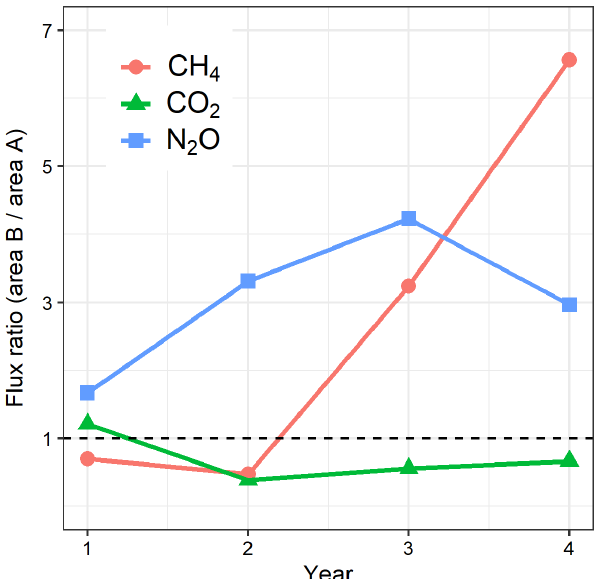
Figure 6. Ratios of annual soil GHG fluxes in area B (mature stand, felled after year 1) to that in area A (mature spruce stand, remain- ing) in Harwood Forest. Note: CH 4 fluxes are presented as absolute values. The dashed line represents ratio = 1 (no difference between